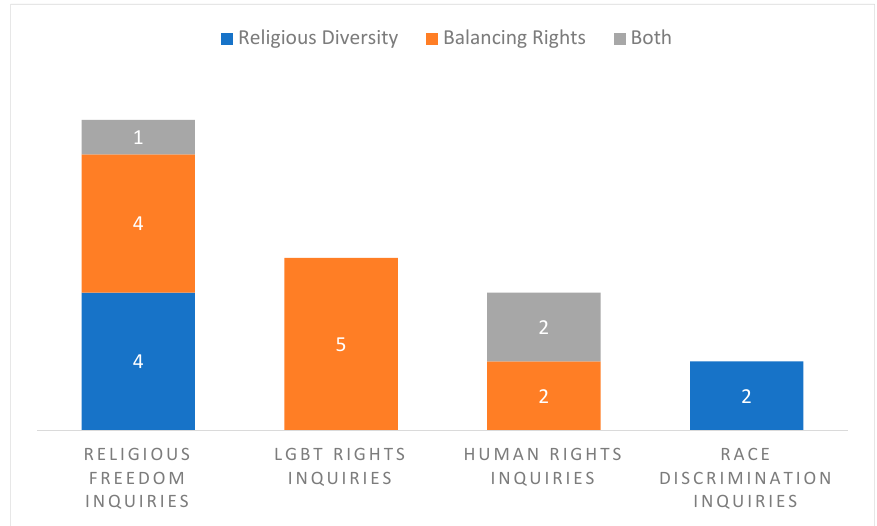
Figure 1. The dominant problem by topic of inquiry.